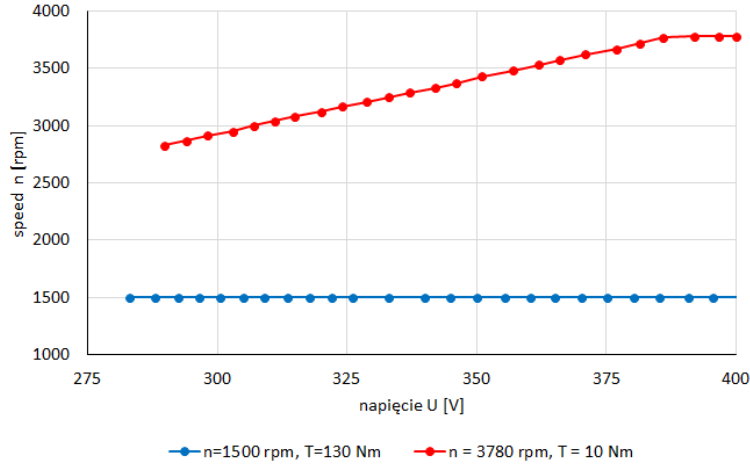
Figure 18. Winch drive operation at a reduced supply voltage.